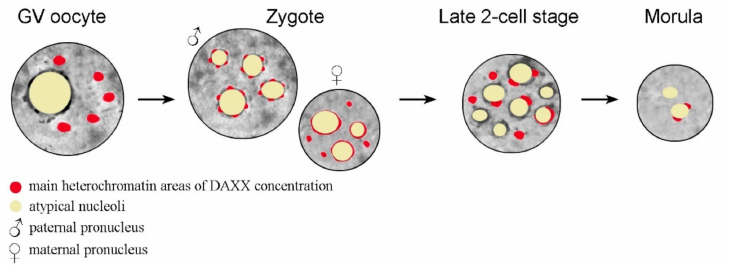
Figure 2. A cartoon illustrating the dynamics of DAXX distribution in the heterochromatin compart- ments during mouse early